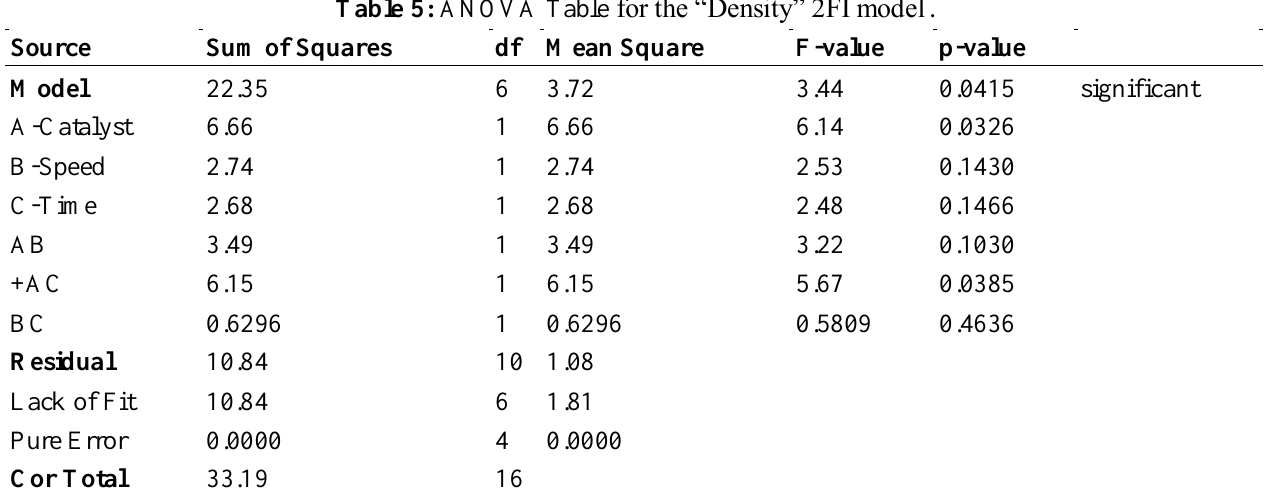
Table 5: ANOVA Table for the “Density” 2FI model.